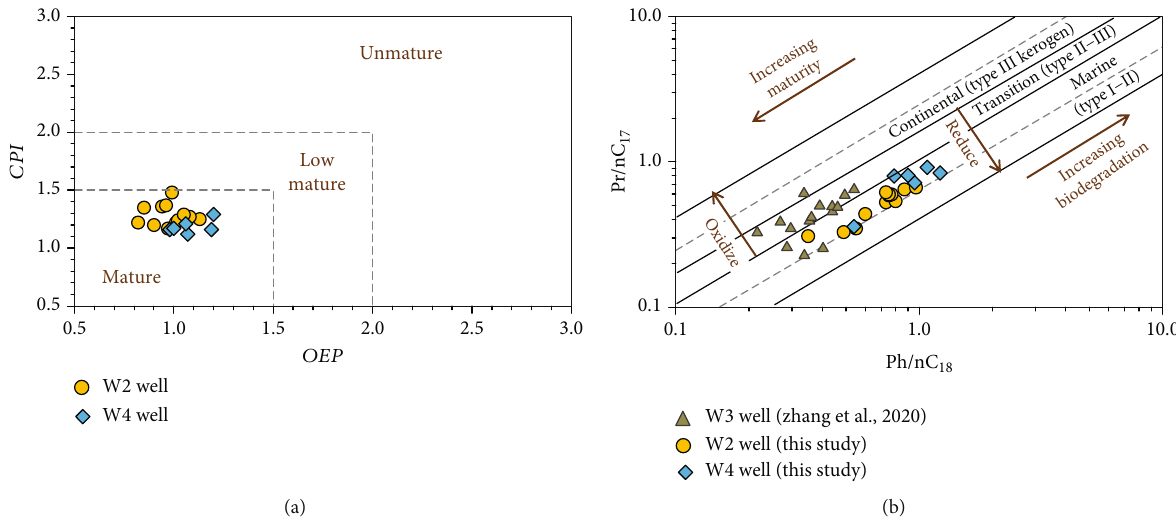
vs. Ph/nC of the Longtan coal series shale (the 17 18